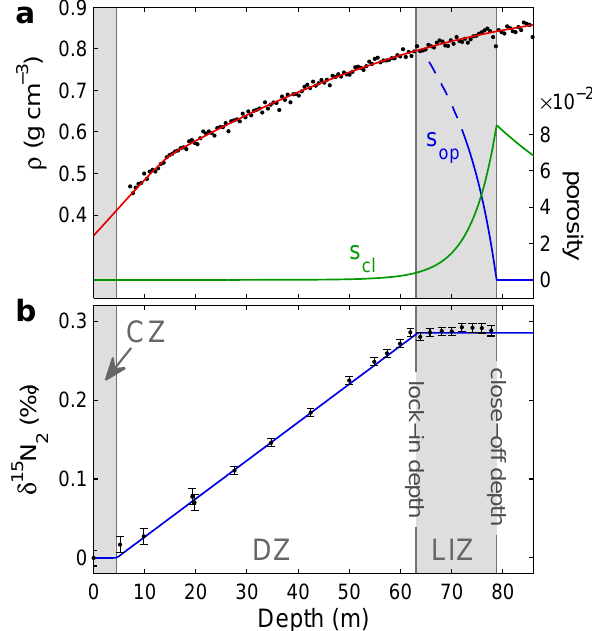
Fig. 1. (a) Firn density ρ (left axis), and the open and closed poros- ity s op and s cl , respectively (right axis). Black dots show firn den- sity measurements in 0.55m segments, the red line is the fit used in this study. Density data were kindly provided by S. J. Johnsen (per- sonal communication, 2009) (b) Gravitational enrichment as shown by δ 15 N 2 , corrected for thermal effects (Severinghaus et al., 2001). The blue line shows the barometric slope 1Mg(z − 4 . 5 )/RT , where we use 1M = 1 × 10 − 3 kgmol − 1 . Convective zone (CZ), diffu- sive zone (DZ) and lock-in zone (LIZ) are indicated by changes in